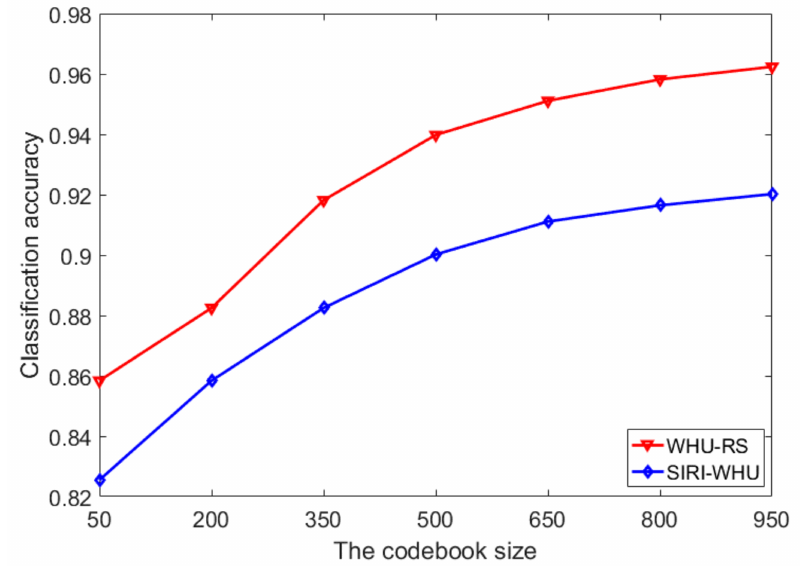
Figure 19. Effect of the codebook size s on the classification accuracy in two